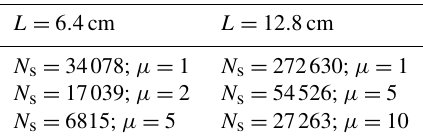
Table 1. Number of super-droplets and their multiplicity for real DNS domains of volume 6 . 4 3 and 12 . 8 3 cm 3